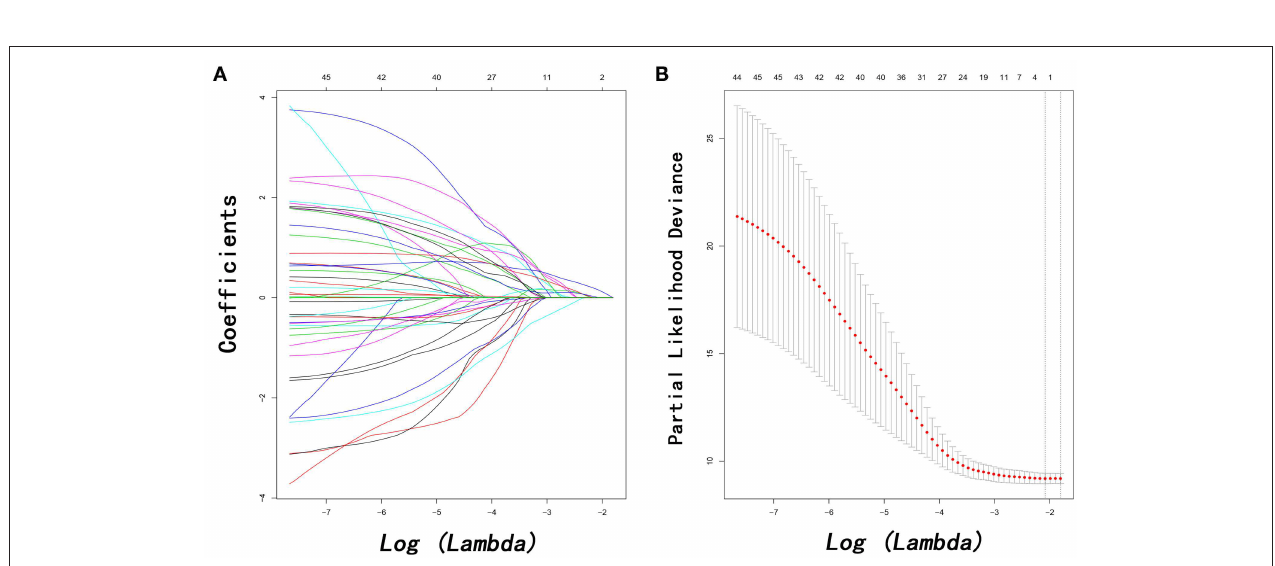
FIGURE 2 | Feature selection using the least absolute shrinkage and selection operator (LASSO) Cox regression model. LASSO coefficient profiles of 48 variables against the log (Lambda) sequence for PPS (A) and tuning parameter (Lambda) selection in the LASSO model used 10-fold cross-validation via minimum criteria for PPS (B) . PPS, post-progression